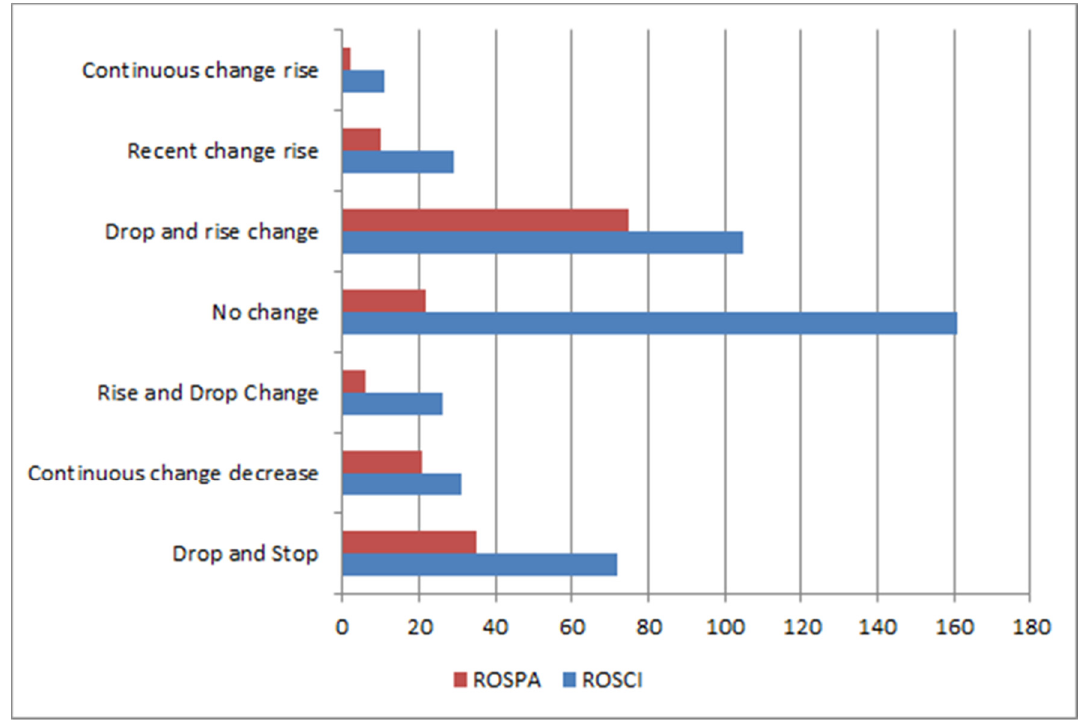
Figure 7. Frequency of each type of dynamics in ROSCI and ROSPA sites.